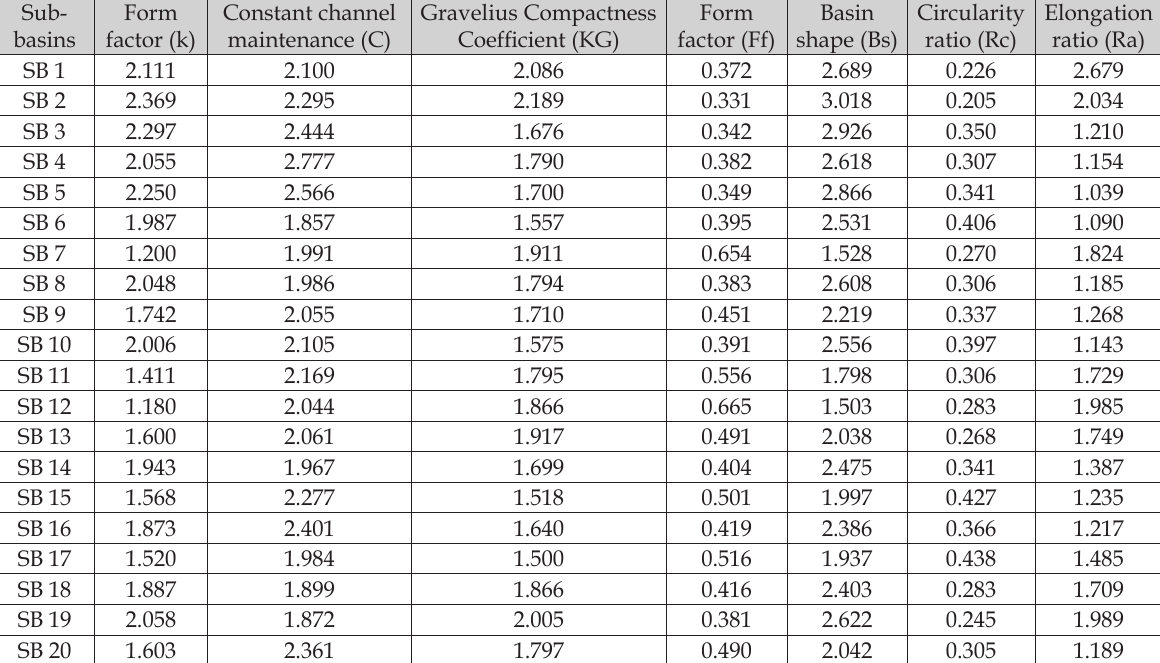
Table 4. Shape parameters of the sub-catchments of the Soungrougrou catchment. Sub-